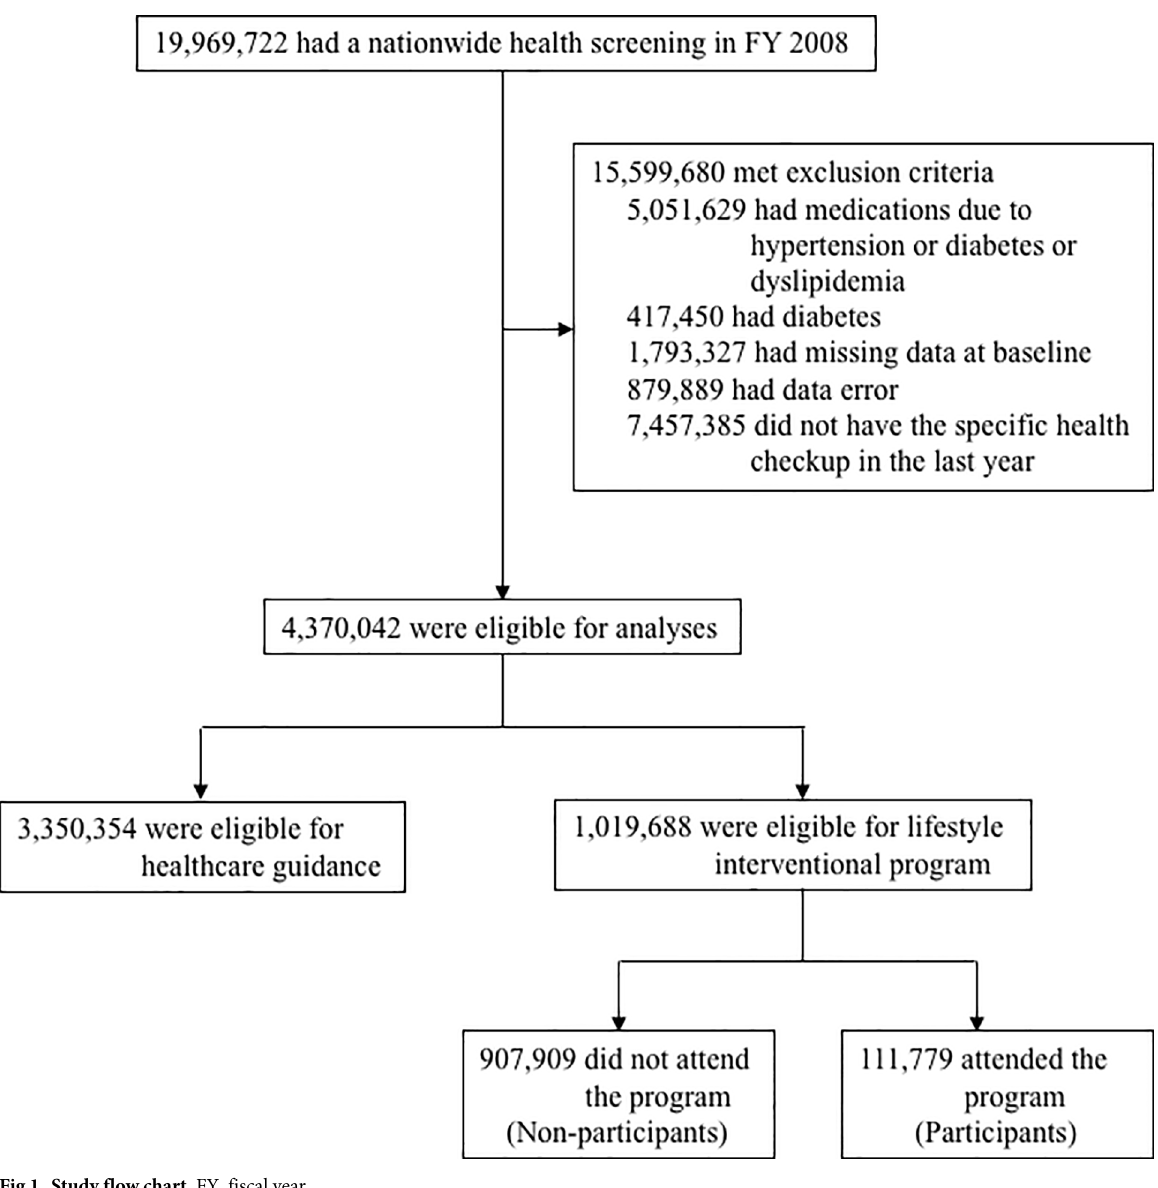
Fig 1. Study flow chart. FY, fiscal